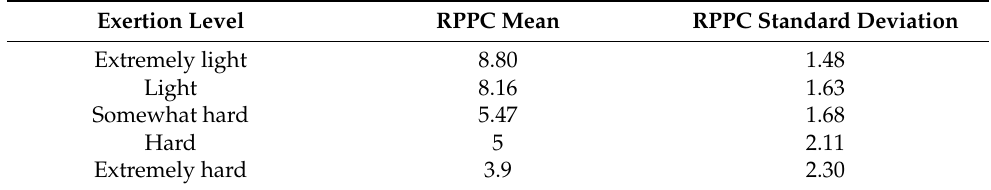
Table 7. ANOVA results for the effect of exertion level on the rate of perceived physical comfort scores. DF: degree of freedom, MS: mean sum of squares, and SS: sum of squares . Source